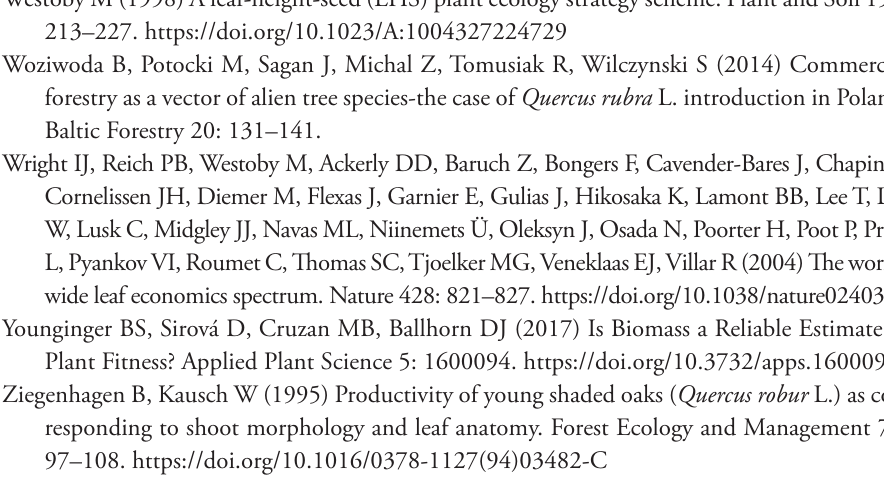
Explanation note: Table S1. Mixed-effects ANOVA models of traits studied (LAR – leaf area ratio [cm 2 g -1 ], lmf – leaf mass fraction, PLA – projected leaf area [cm 2 ],